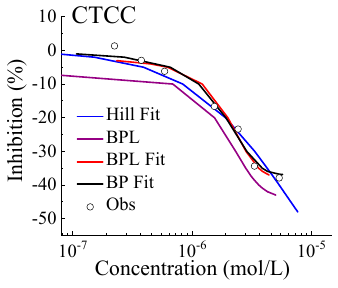
Figure 2. Modeling left segment of concentration–response curve of chlortetracycline hydrochloride (CTCC) inhibiting Allivibrio fischeri . Note: Circle: observed data; Black line: BP fit; Red line: BPL fit; Blue line: Hill fit; Violet line: BPL modeling based on BP parameters.